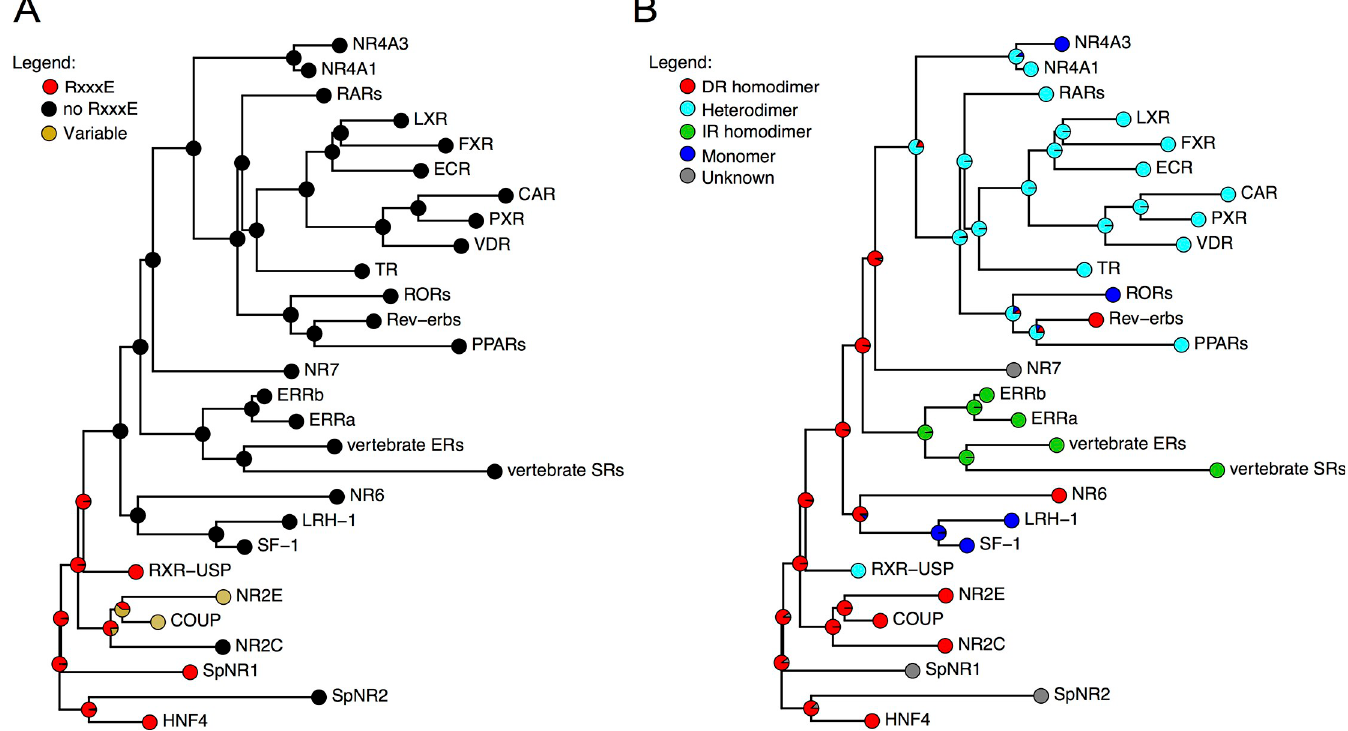
Fig 3. Evolution of the RxxxE motives compared to the dimerization modes during the history of the NR family. A. Evolution of RxxxE motives, as reconstructed using ancestral mapping. B. Evolution of dimerization modes. Source files and script are provided in dryad under the following doi:10.5061/dryad.kkwh70s48.